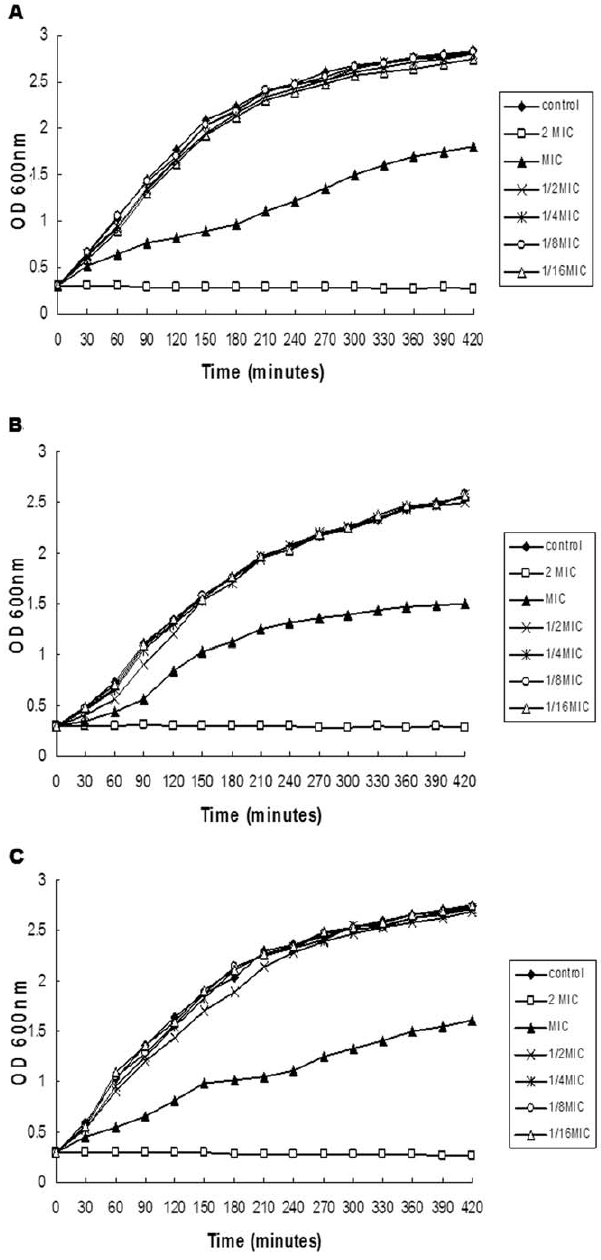
Figure 1. Growth curves of S.aureus after exposure to various concentrations of perilla oil. S. aureus strains ATCC 29213 (A), MRSA 2985 (B), and MRSA 3701 (C) were grown in the presence of increasing concentrations of perilla oil at 37 u C with agitation at 200 rpm under aerobic conditions, and cell growth was monitored by measuring the OD values at 600 nm at the indicated time points. These curves represent one of three reproducible experiments.